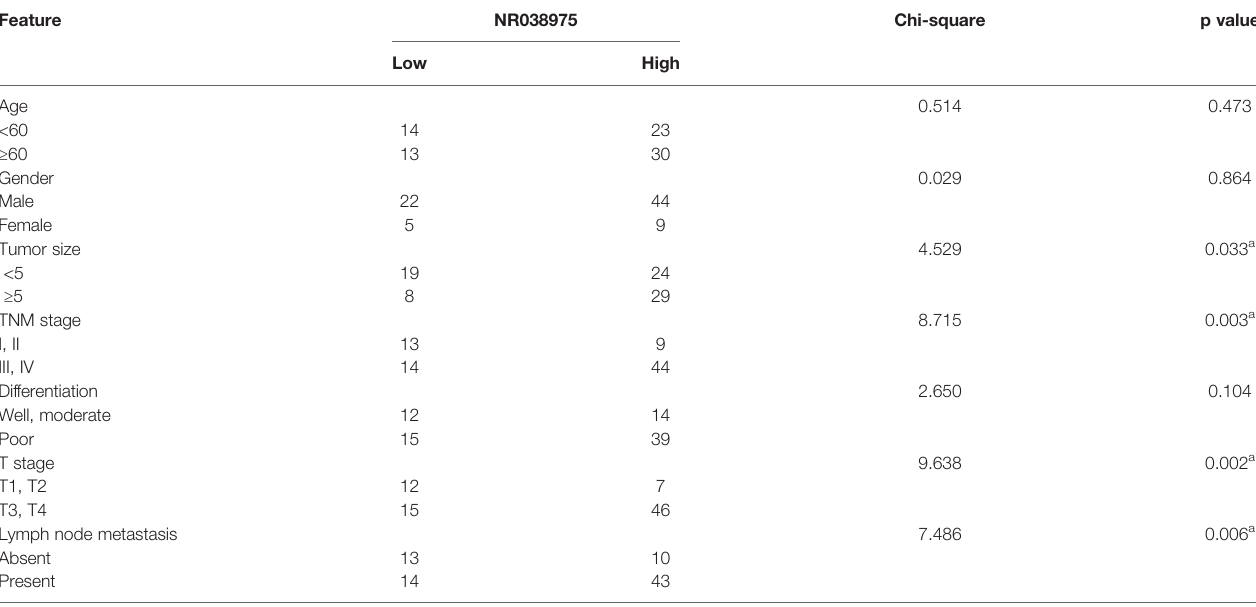
TABLE 1 | Correlation between NR038975 expression and clinicopathologic features in 80 GC patients.